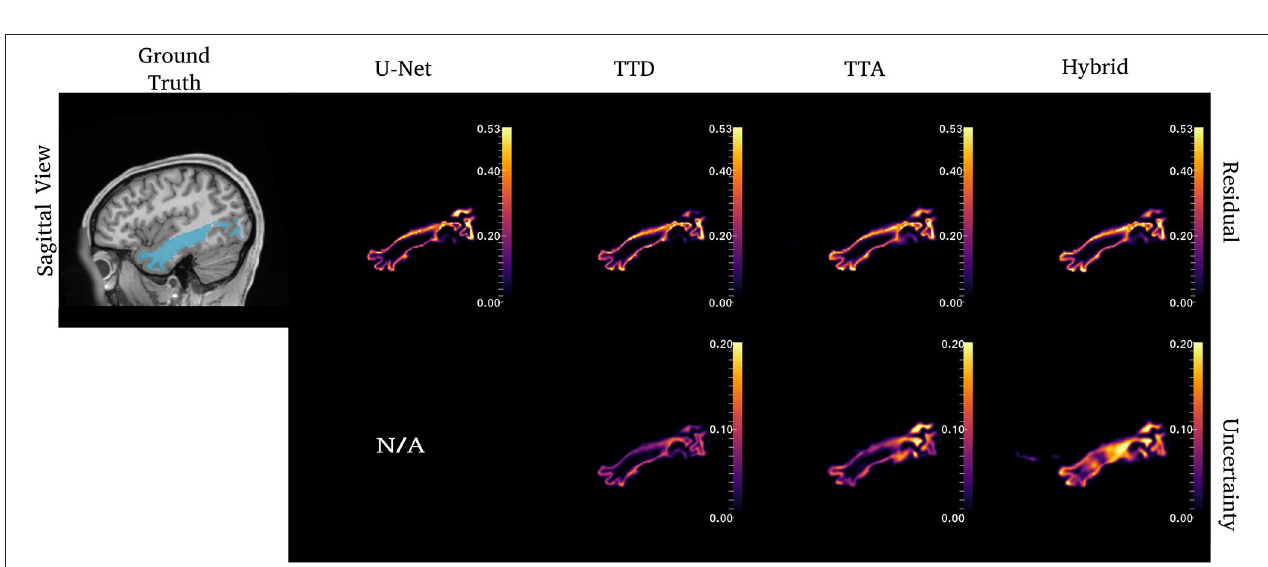
FIGURE 4 | Uncertainty and residuals maps for the left CST tract. Red arrows point to one area of high uncertainty within the ground truth. This region may not represent real CST anatomy. Uncertainty maps are not applicable (N/A) for the deterministic U-Net approach.